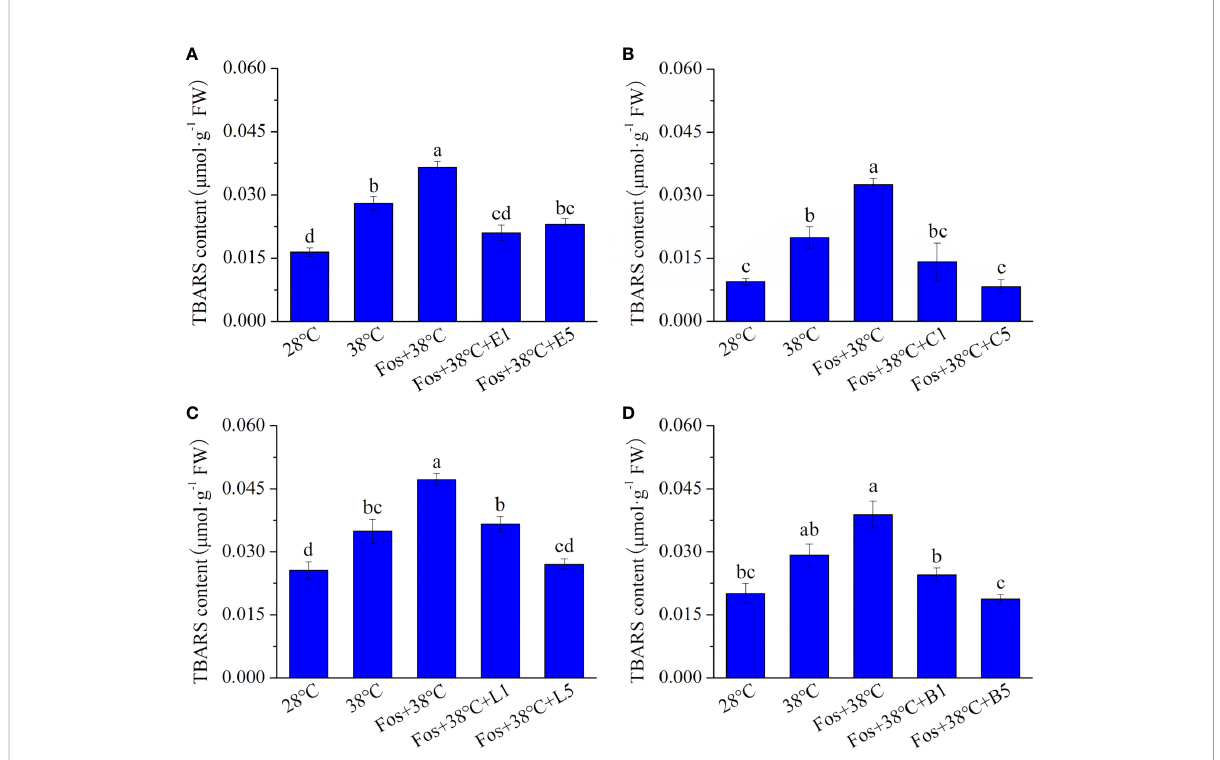
FIGURE 2 Effects of the uppermost monoterpenes on thiobarbituric acid reactive substance (TBARS) content in C . camphora . (A) Eucalyptol chemotype (EuL); (B) Camphor chemotype (CmR); (C) Linalool chemotype (LnL); (D) Borneol chemotype (BeL). 28°C, 38°C, and Fos+38°C: C . camphora was treated with normal temperature, high temperature, and high temperature with fosmidomycin (Fos) pretreatment, respectively. Fos+38°C +E1 and Fos+38°C+E5: EuL blocked monoterpene synthesis with Fos was fumigated with 1 and 5 m M eucalyptol at 38°C, respectively. Fos+38°C +C1 and Fos+38°C+C5: CmR blocked monoterpene synthesis with Fos was fumigated with 1 and 5 m M camphor at 38°C, respectively. Fos+38° C+L1 and Fos+38°C+L5: LnL blocked monoterpene synthesis with Fos was fumigated with 1 and 5 m M linalool at 38°C, respectively. Fos+38°C +B1 and Fos+38°C+B5: BeL blocked monoterpene synthesis with Fos was fumigated with 1 and 5 m M borneol at 38°C, respectively. Different lowercase letters indicate the signi fi cant difference at P < 0.05. Means ± SE (n =